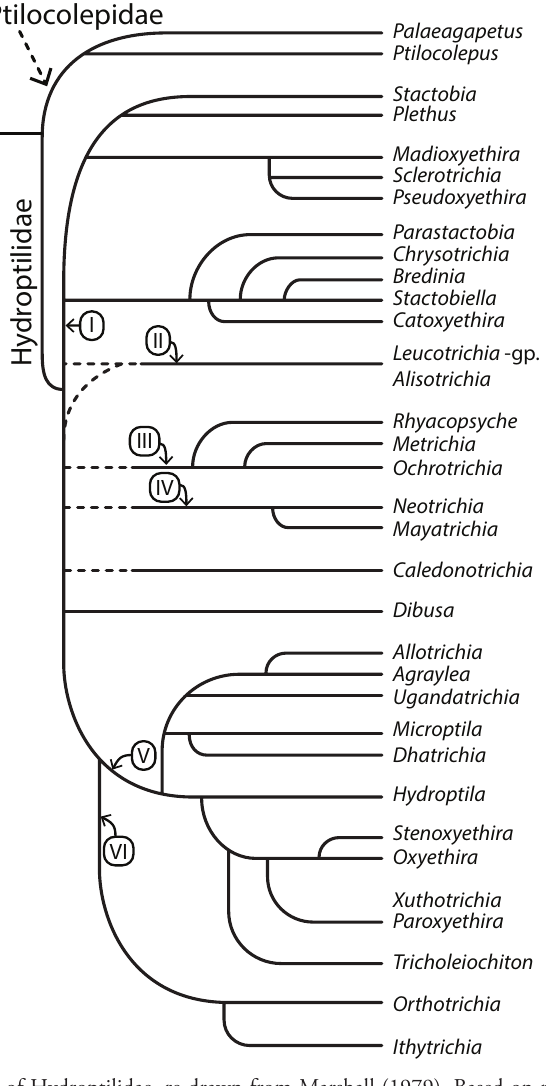
Figure 1. Phylogeny of Hydroptilidae, re-drawn from Marshall (1979). Based on morphological data; generic relationships ( I Stactobiini II Leucotrichiini III Ochrotrichiini IV Neotrichiini V Hydroptilini VI